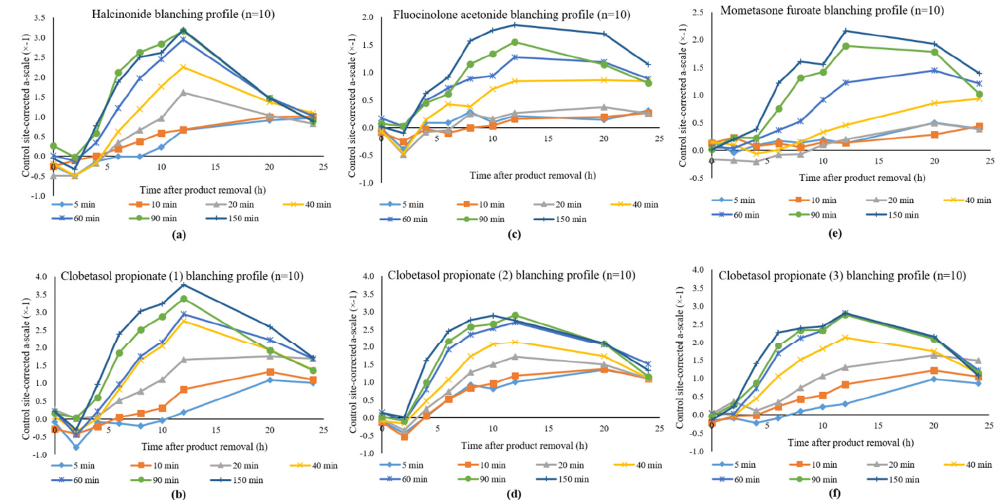
Figure 2. Blanching profiles for ( a ) halcinonide; ( b ) clobetasol propionate (1); ( c ) fluocinolone ace- tonide; ( d ) clobetasol propionate (2); ( e ) mometasone furoate; ( f ) clobetasol propionate